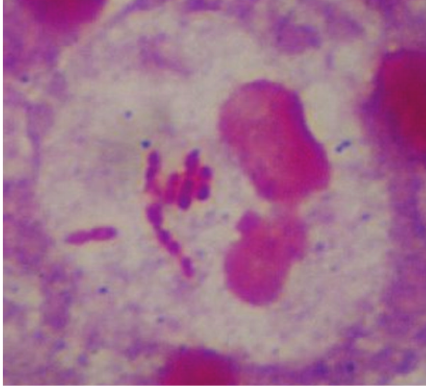
Figure 2: Case 1 Gram stain. Gram-negative bacilli seen intracellu- larly (100x magnification).